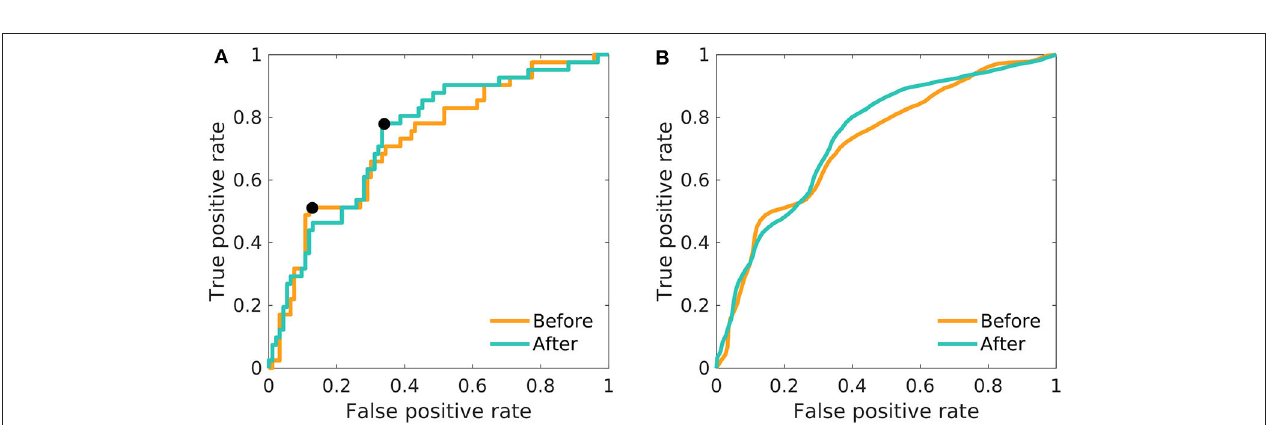
FIGURE 2 | The ROC curves of one-dimensional logistic regression. Differences between men and women in the mean relative beta power; before as well as after the treatment. (A) The model was fitted on the whole dataset using the mean relative beta power. The black pointers indicate the position on the ROC curve, for which the overall accuracy is reported in Table 1 . (B) The model was fitted 100-times on a random balanced subsample of 80 patients, and the resulting ROC-curves were